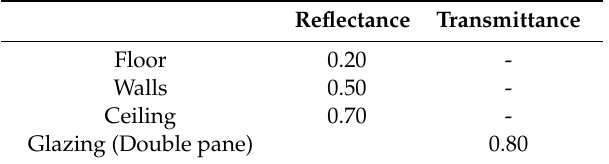
Table 2. Construction properties of the model.